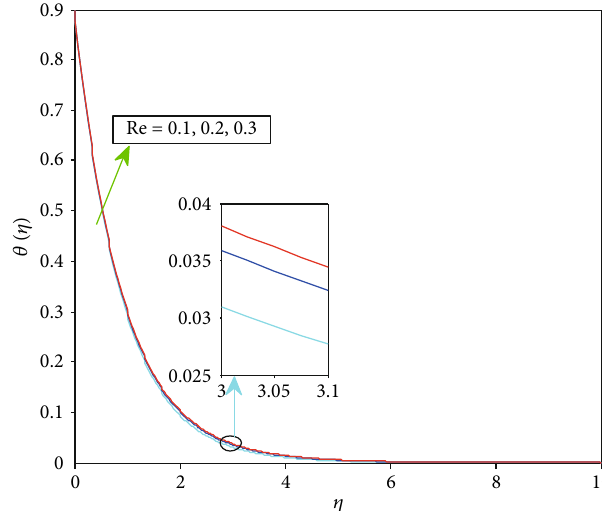
Figure 15: Temperature distribution for di ff erent values of the Reynolds